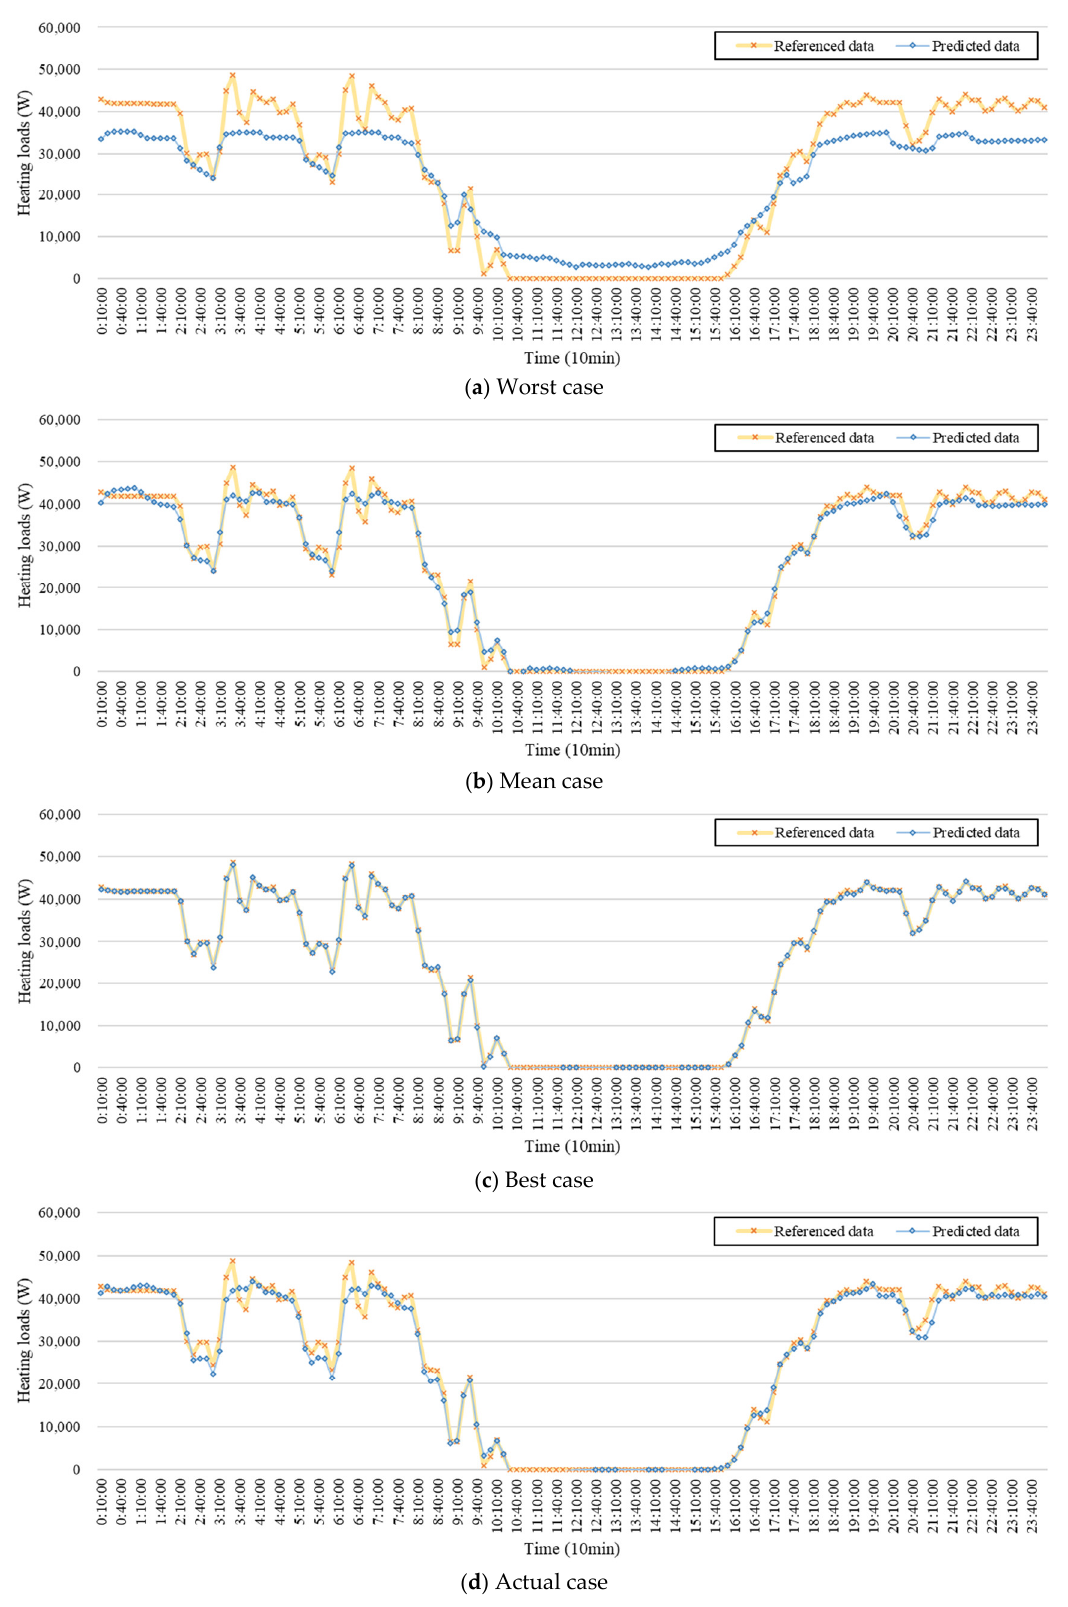
Figure 7. Comparison of the heating loads with the timestep (referenced data vs. predicted data).